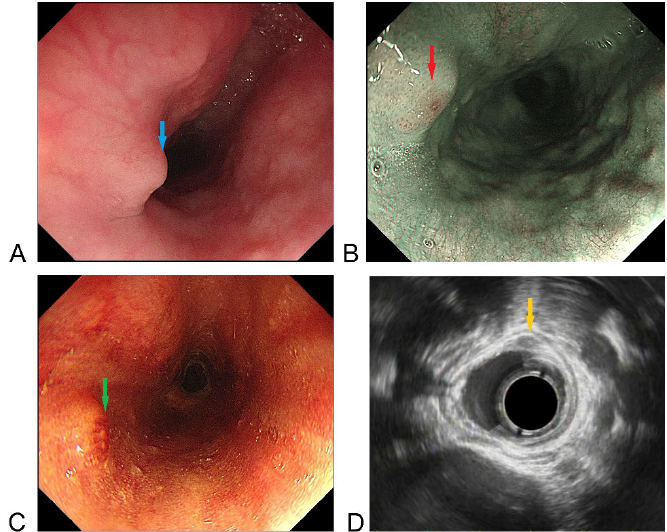
Figure 1. Endoscopic views of the esophageal tumor. ( A ) Endoscopy shows a protruding submucosal tumor-like lesion with slightly rough mucosa at the cervical esophagus about 20 cm from the incisors (blue arrow). ( B ) Narrow band imaging shows a barely visible intra-epithelial papillary capillary loop as brown dots (red arrow). ( C ) Light staining and over staining spots can be seen on the mucosal surface after iodine staining (green arrow). ( D ) Endoscopic ultrasonography shows a hypoechoic mass in the mucosal and submucosal layers, with dot hyperechoic in the center of the mass, clear boundary and maximum size of 2.9 × 5.2 mm (yellow arrow).